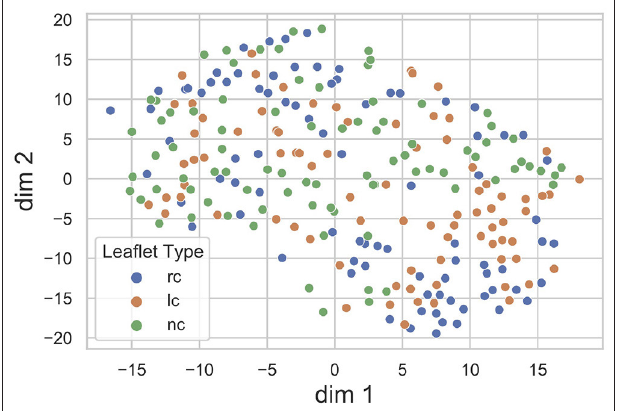
FIGURE 4 | Sketch of our proposed approaches. As a direct mapping between the two data domains, also called image to image translation , is barely possible in the given scenario, we propose to encode the data to latent space descriptions using representation learning. Then, the latent leaflet description can be predicted based on the 3D ultrasound image, called shape estimation , or based on the latent description of the ultrasound volume, referred to as domain mapping .